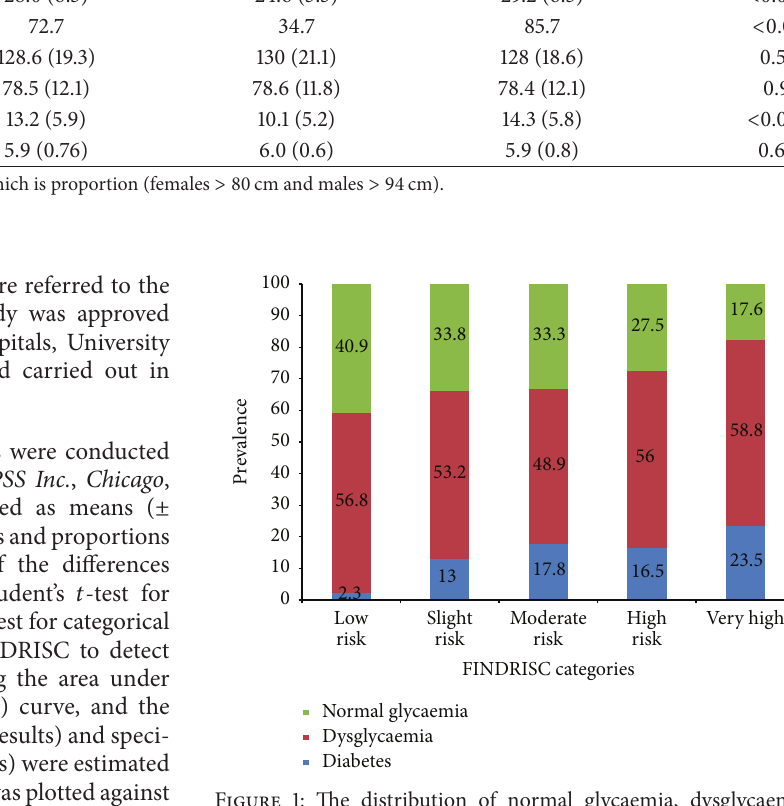
Figure 1: The distribution of normal glycaemia, dysglycaemia, and undiagnosed T2D within the FINDRISC categories among the participants. The figures are percentage prevalence within the FINDRISC